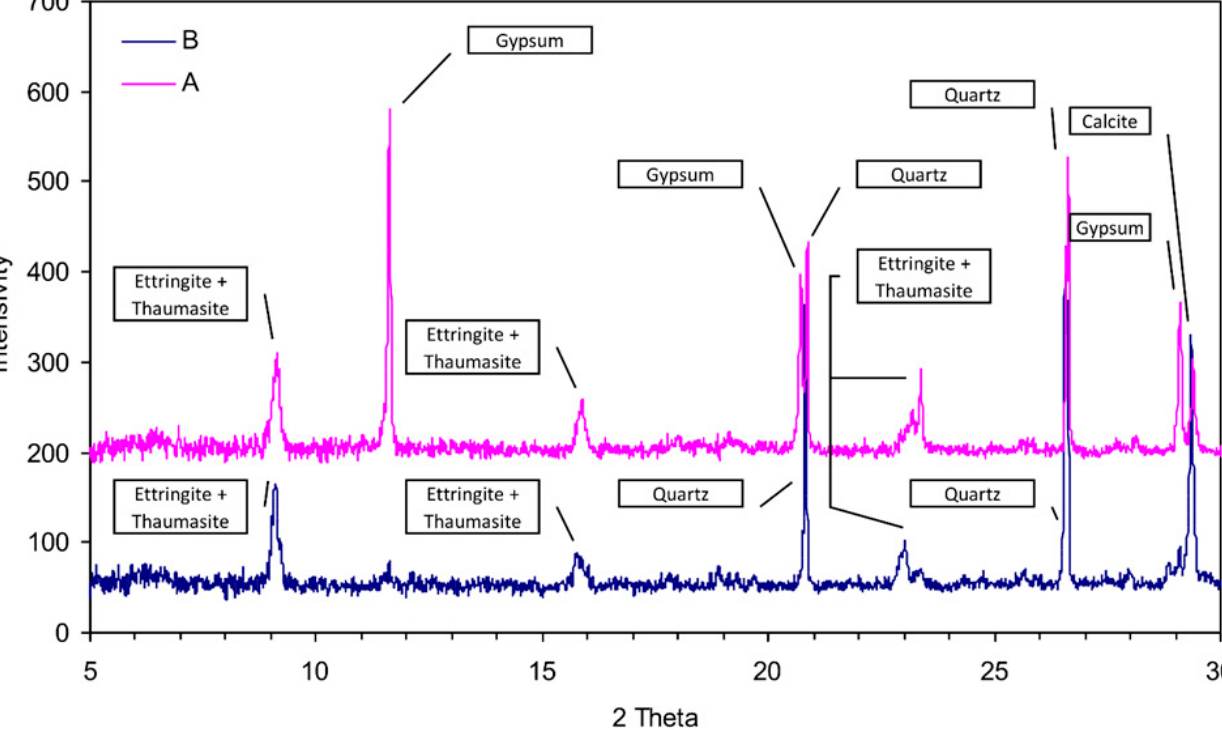
Figure 6. The XRD analysis of the selected mortar samples (5 °C temperature, 360 days), (A) - binder composition: 85% - CEM I 32,5R + 15% FBC FA BC, stored in MgSO 4 solution, (B) - binder composition: 85% - CEM I 32,5R + 15% FBC FA HC, stored in Na 2 SO 4 solution.